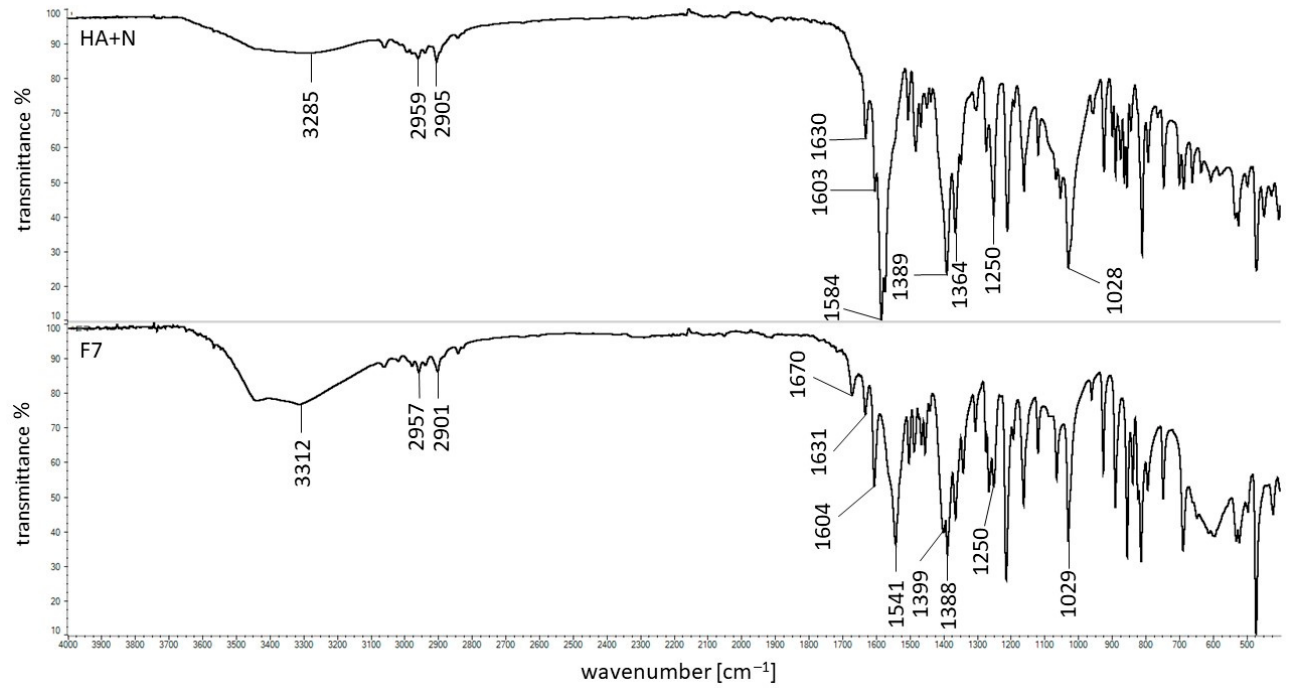
Figure 10. FTIR spectra of the physical mixture of HA + N and the formulation F7.